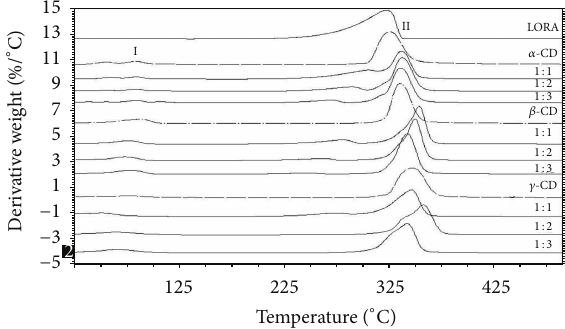
Figure 3: DTG curves for LORA, CDs, and LORA: 𝛼 -CD, LORA: 𝛽 - CD, and LORA: 𝛾 -CD complexes (ratios 1: 1, 1:2, and 1: 3). Loss of masses (I) and (II), obtained under a dynamic N 2 atmosphere (100mL ⋅ min −1 ) and heating rate of 10 ∘ C min −1 .